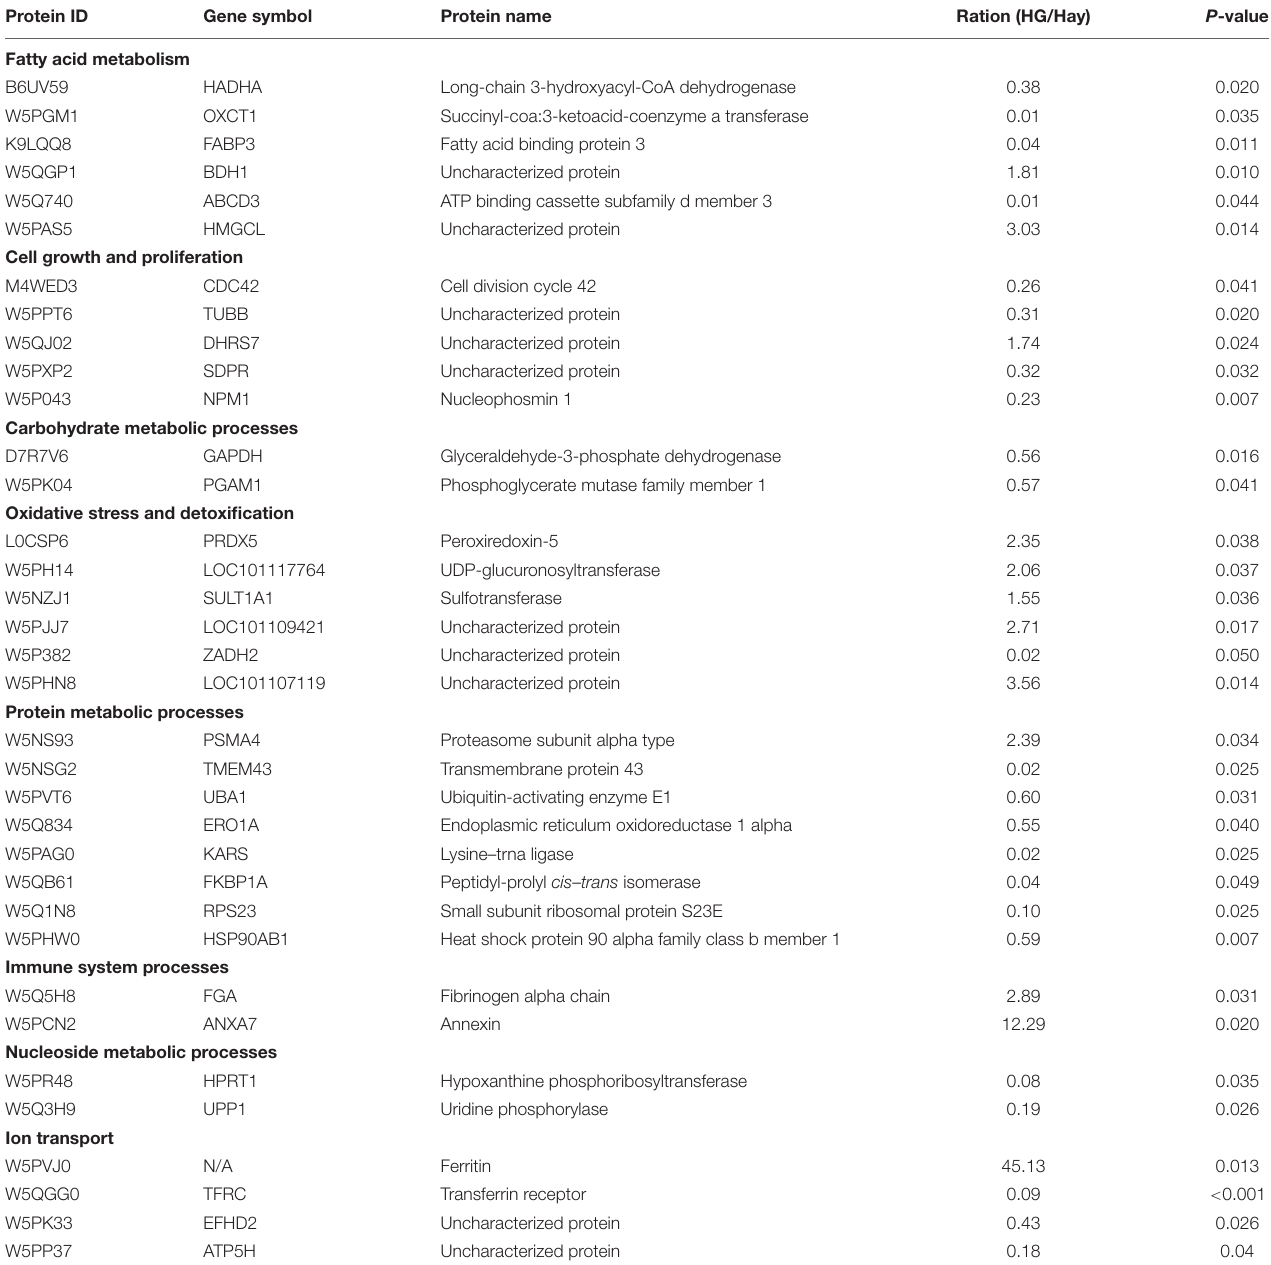
TABLE 2 | List of differentially expressed proteins in rumen epithelium from HG group and Hay group. Protein ID Gene symbol Protein name Ration (HG/Hay) P